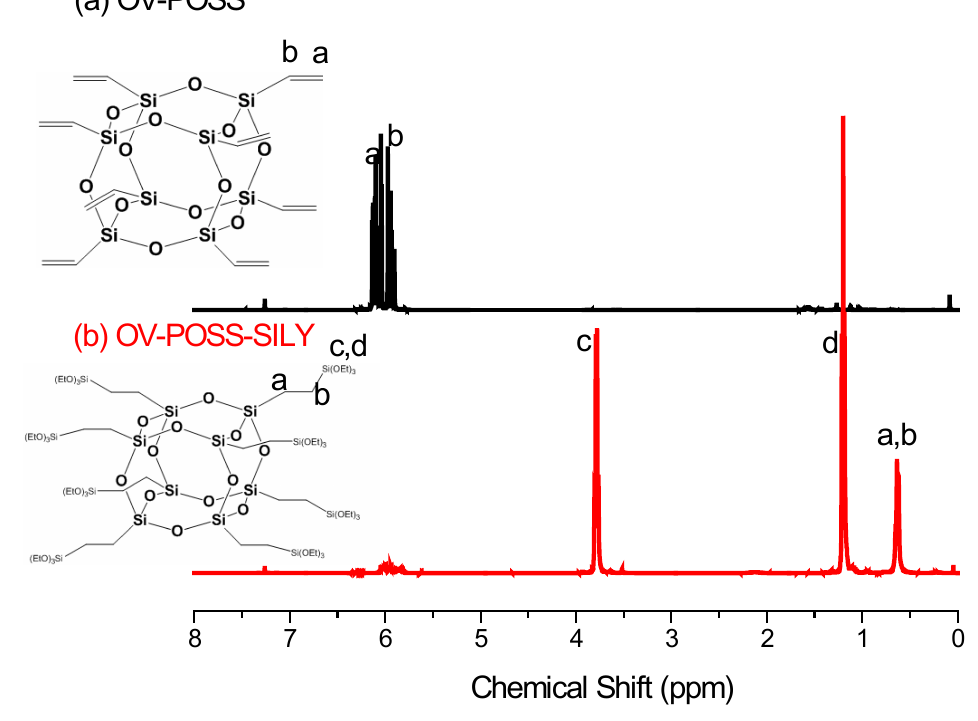
Figure 1. 1 H nuclear magnetic resonance (NMR) spectra of OV-POSS and OV-POSS-SILY.